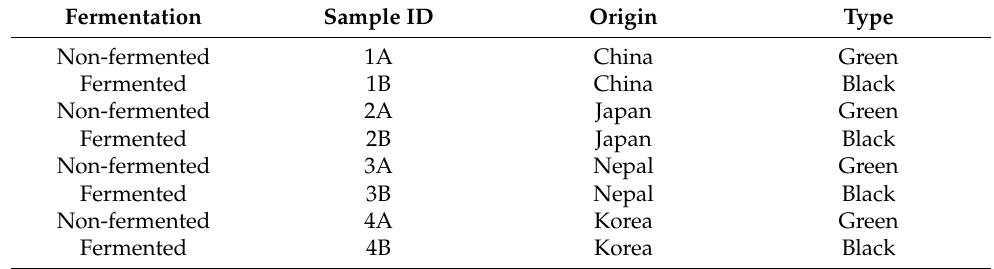
Table 1. Characterization of tea